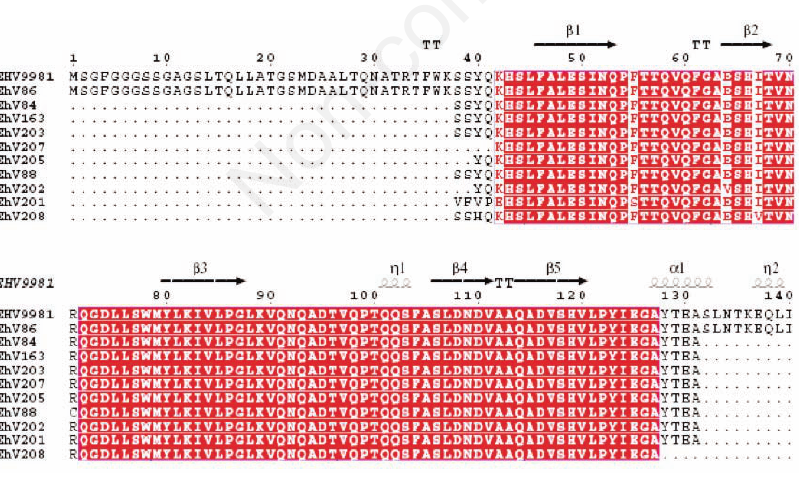
Figure 1. Multiple sequence alignment of the N-terminal conserved part of Major Capsid Protein (MCP) amino acid sequence from EhV isolates. Secondary structure prediction of the region suggests an α -helix and five β -sheets as indicated. Structural elements are shown using the program ESPrip thttp://espript.ibcp.fr/ESPript/ESPript/index.php Accession numbers of the proteins as extracted using the Entrez web service (http://www.ncbi.nlm.nih.gov/Entrez/protein.html) are: EhV99B1 (ACH6963), EhV86 (GAI65508.2), EhV84 (AAL58850.1) ， EhV163 (AAL58852.1), EhV203 (AAL58856.1), EhV207 (AAL58854.1), EhV205 (AAL58855.1), EhV88 (AAL58851.1), EhV202